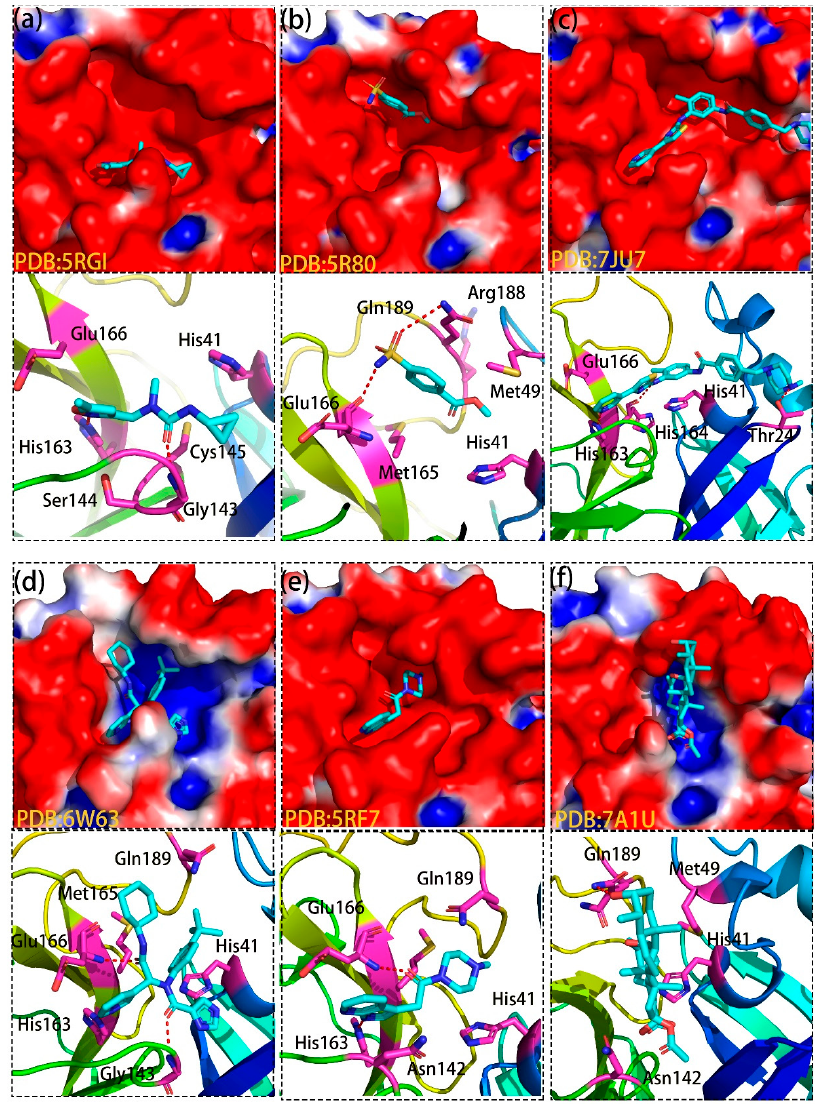
Figure 3. Six non-covalent binders in different substrate-binding subsites of M pro . Six binders are randomly selected from 6 groups and observed to bind to different parts of the active site in M pro . Bound compounds are depicted as cyan sticks and the surface of M pro is colored by potential on solvent accessible surface. The binding modes of 5RGI ( a ), 5R80 ( b ),7JU7 ( c ), 6W63 ( d ), 5RF7 ( e ), 7A1U ( f